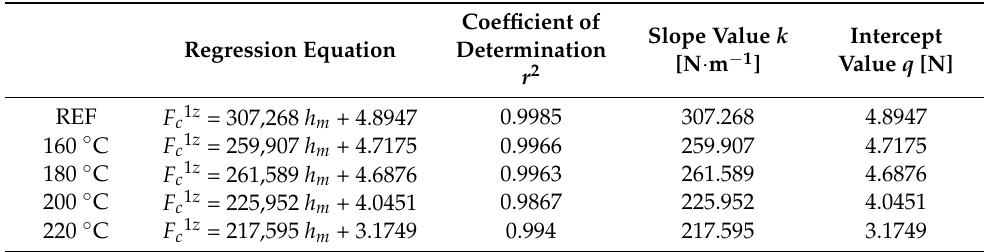
Table 5. Comparison of fracture parameters.